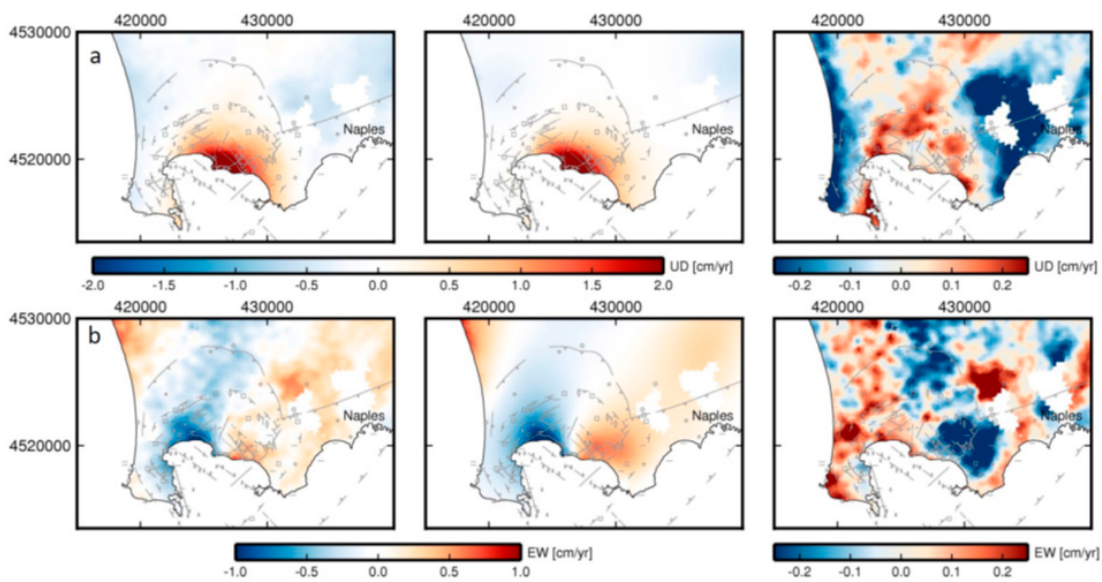
Figure 13. ( a ) Observed vertical displacement rate (left), cm / yr, for the subsidence period, 2005–2007; modelled vertical displacement rate from inversion (center); and residual of observed and modelled displacements (right). ( b ) Observed EW displacement rate (left), cm / yr, 2005–2007; modelled EW displacement from inversion (center); and residual of observed and modelled displacements (right). Images were saturated at the corresponding scales in order to improve comparison and highlight di ff erences among panels [53].